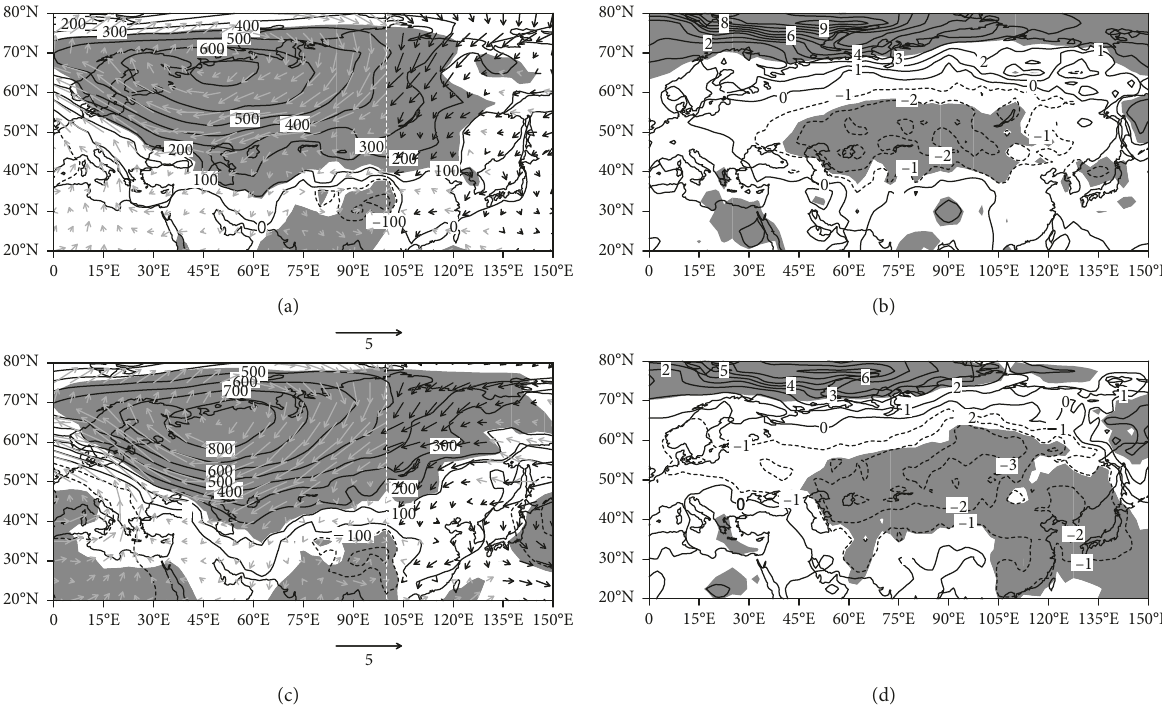
Figure 5: Composite differences for the (a) SLP (shaded and contour; unit: Pa), wind (vector; unit: m · s − 1 ) at 850 hPa, and (b) surface air temperature (shaded and contour; unit: ° C) between selected low OBKI years and high OBKI years in September. (c, d) The same as (a) and (b) but for the composite differences between the selected low DBKI years and high DBKI years in September. The shading denotes significance exceeding 0.1. The black vectors indicate winds with a northerly component over the area east of 100 ° E.